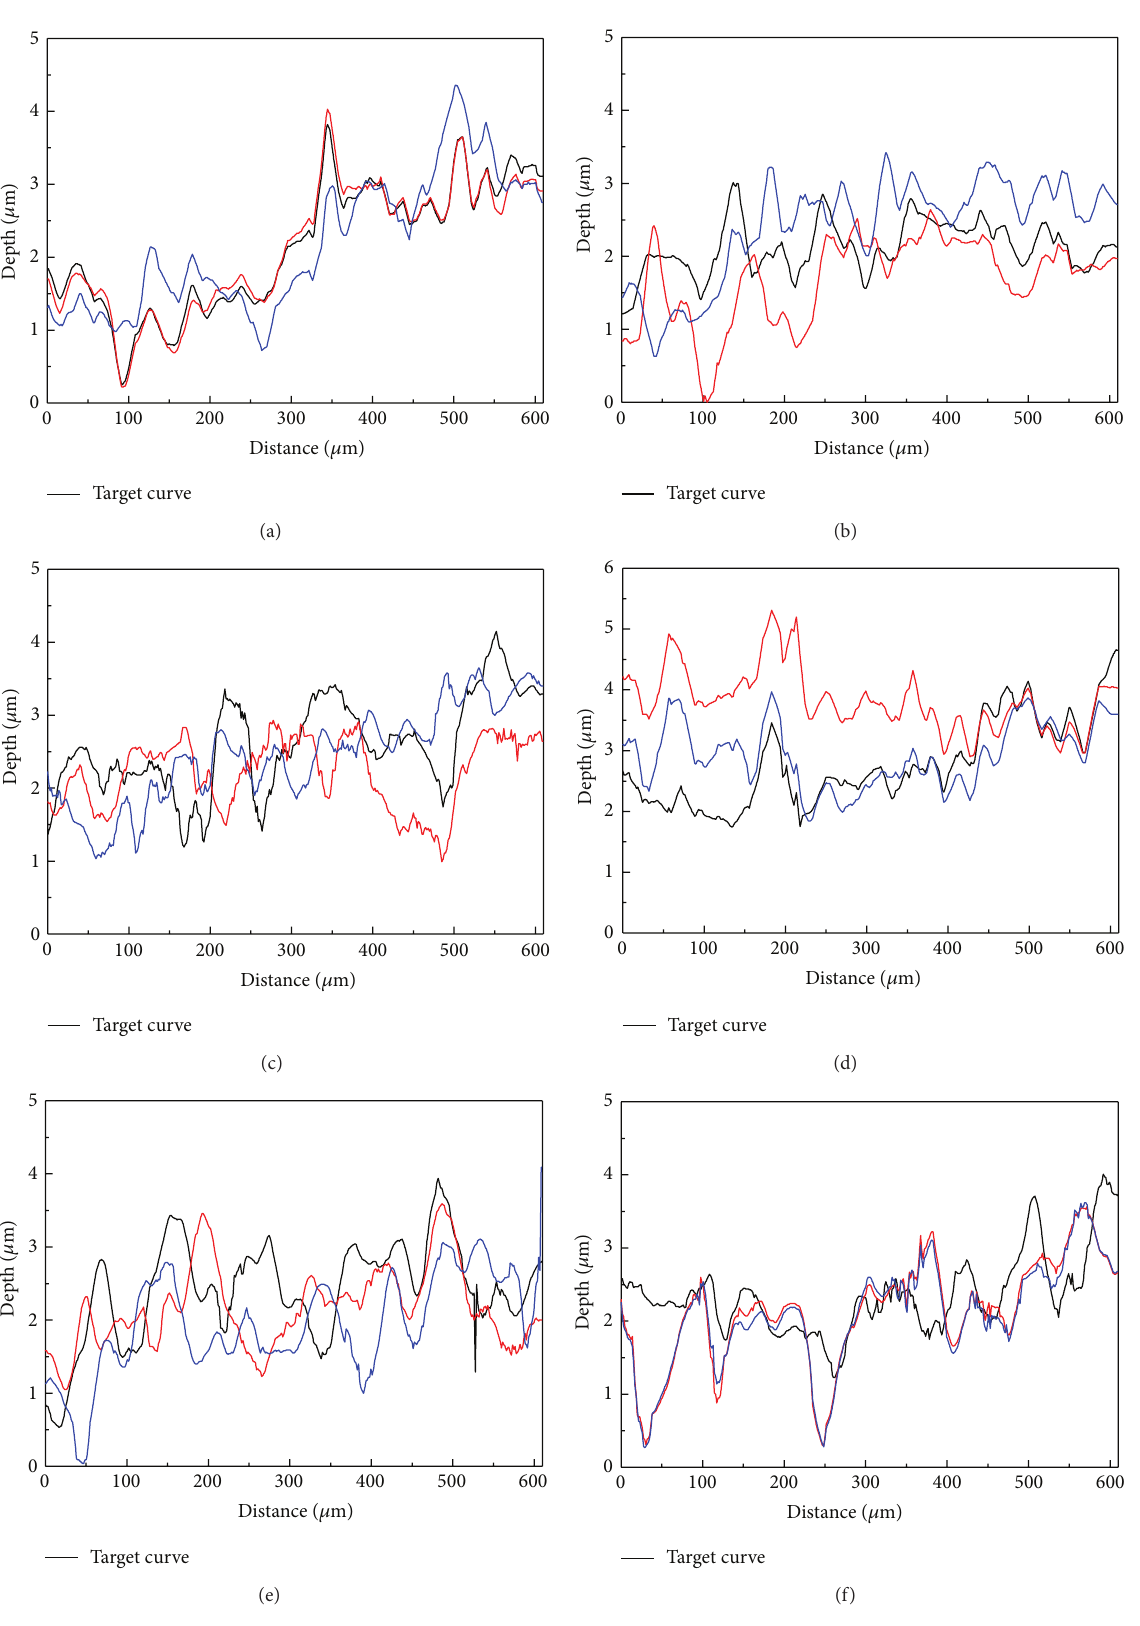
Figure 16: Surface elevation curves of laser cladding specimens after impact: (a) case 1, (b) case 2, (c) case 3, (d) case 4, (e) case 5, and (f) case